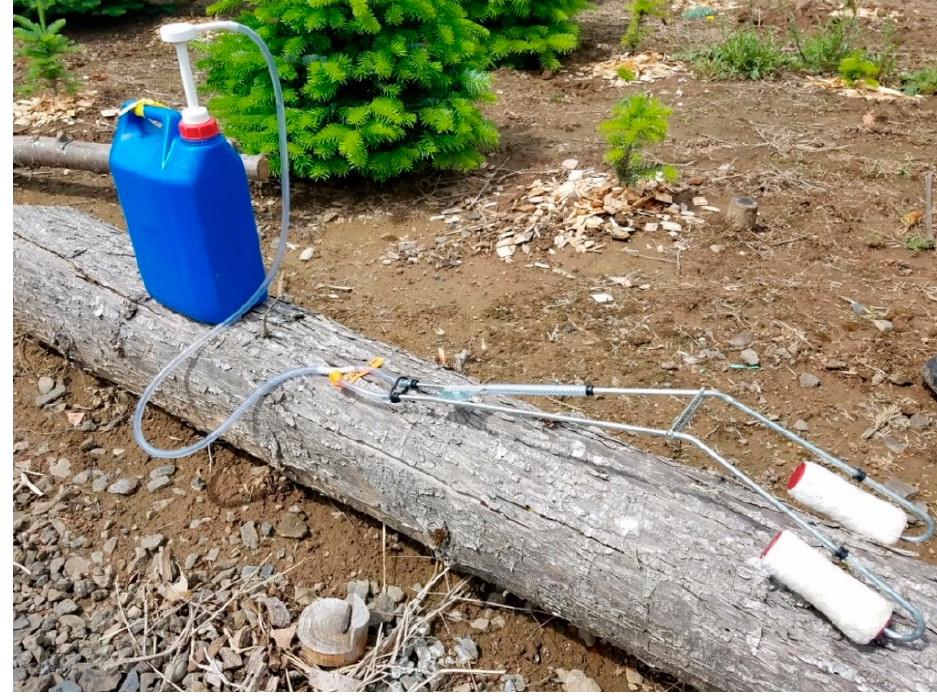
Figure 1. Easy Roller applicator.